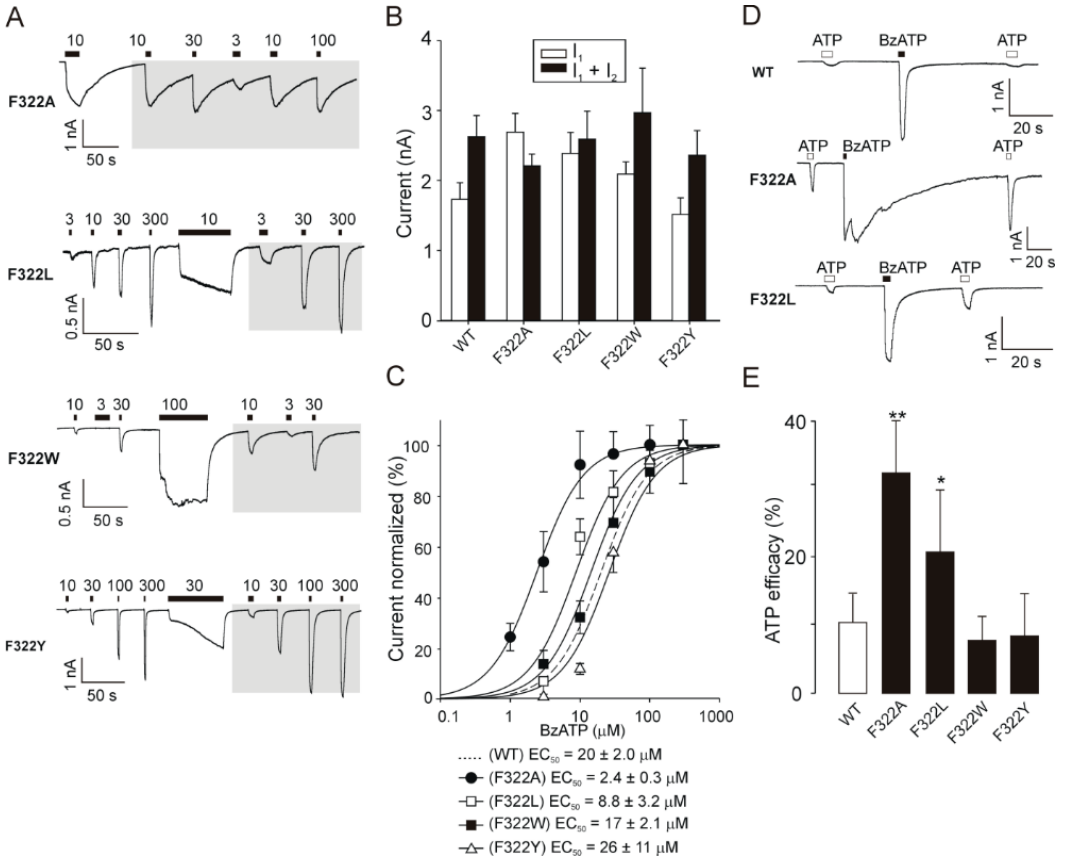
Figure 4. Rescue of receptor function by replacing F322 with a hydrophobic aliphatic or an aromatic residue. ( A ) Example records of BzATP-induced responses mediated by the F322A, F322L, F322W, and F322Y receptors. ( B ) The amplitude of 300 µM BzATP-induced initial (I 1 ) and maximum (I 1 +I 2 )